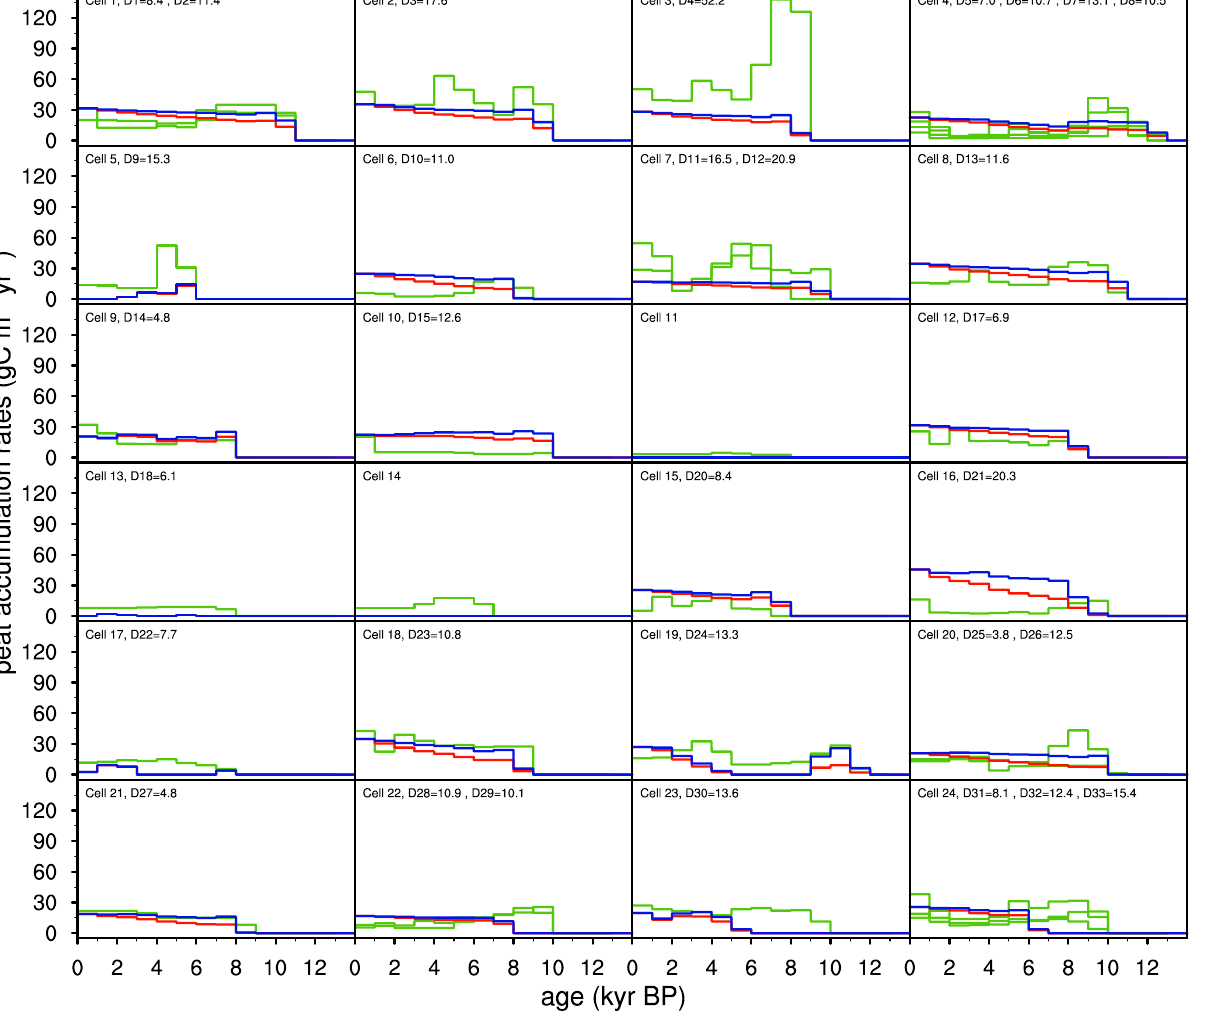
Fig. A1. LPX simulations of gross (blue) and apparent (red) peat accumulation rates for grid cells (1–24), where peat-core data of apparent C accumulation rates (green) are available. Multiple sites may be located within the same model grid cell. RMSD for the 33 individual sites (D and site no. as in Table 1 of Yu et al., 2009) are given in gCm 2 yr − 1